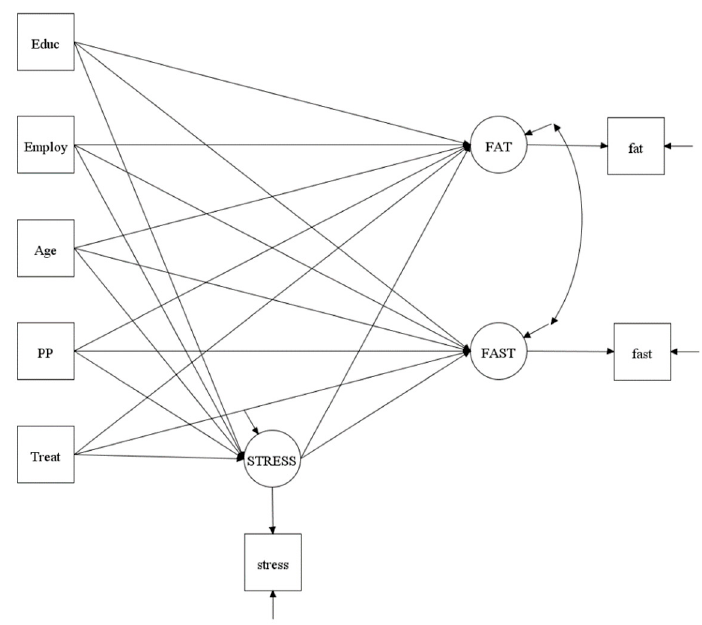
Figure 1. Structure of Mediation Model Testing. Squares are used to indicate manifest or single item variables, whereas circles are used to represent unmeasurable latent variables. Treat (intervention) was an exogenous variable (a predictor or an independent variable). FAT (fat intake) and FAST (fast food intake) were endogenous variables (outcome or dependent variables). STRESS (perceived stress) was a mediator (an endogenous variable). Educ (education), Employ (employment status), age, and PP (postpartum period) were covariates.